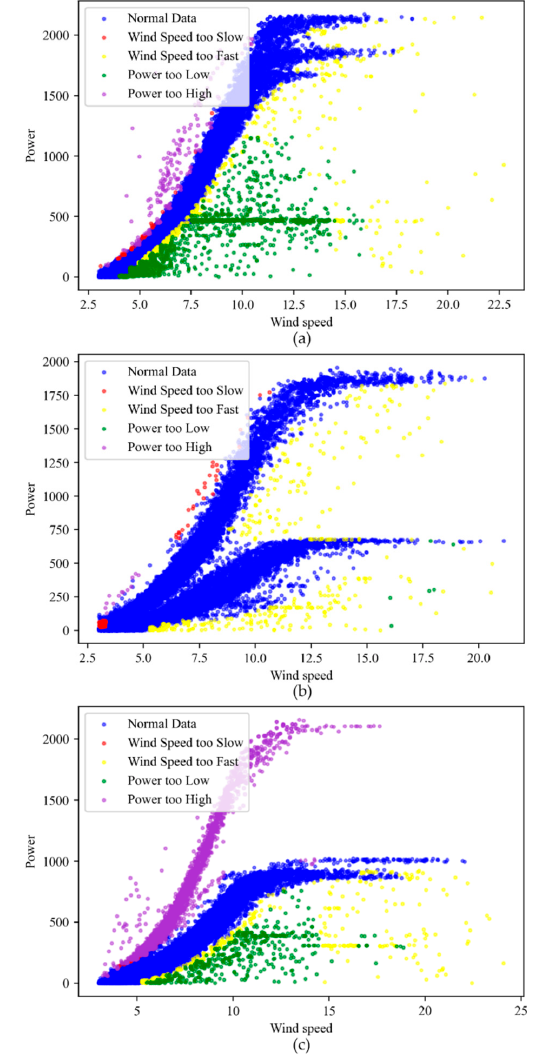
Figure 6. Three wind turbines treated by quartile method: ( a ) #1 wind turbine; ( b ) #2 wind turbine; ( c ) #3 wind turbine.